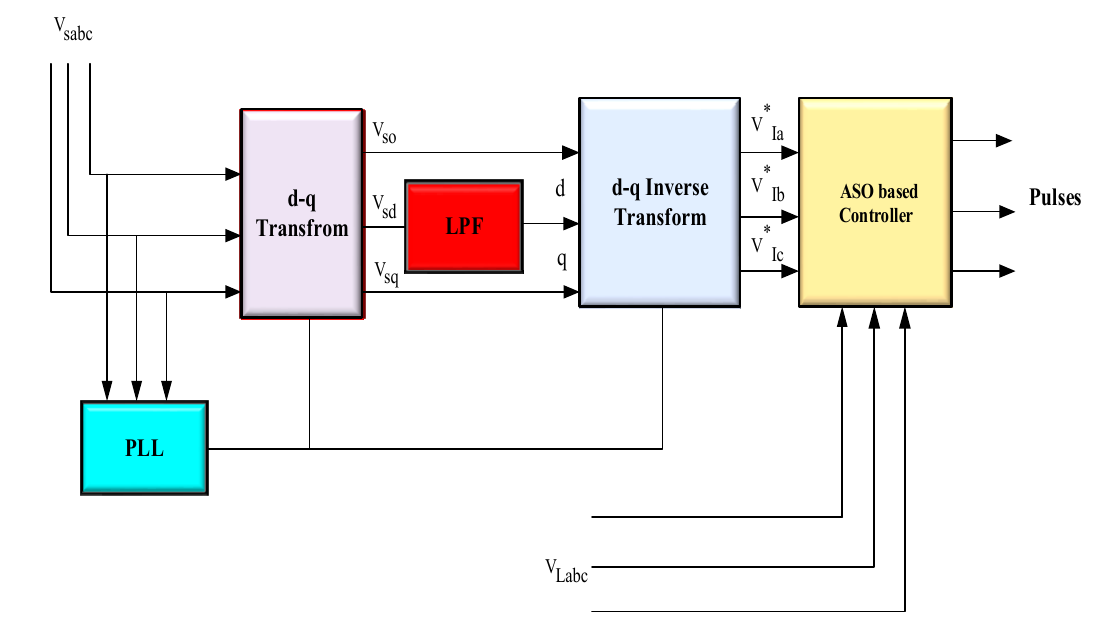
Figure 5. Block diagram of Series APF.